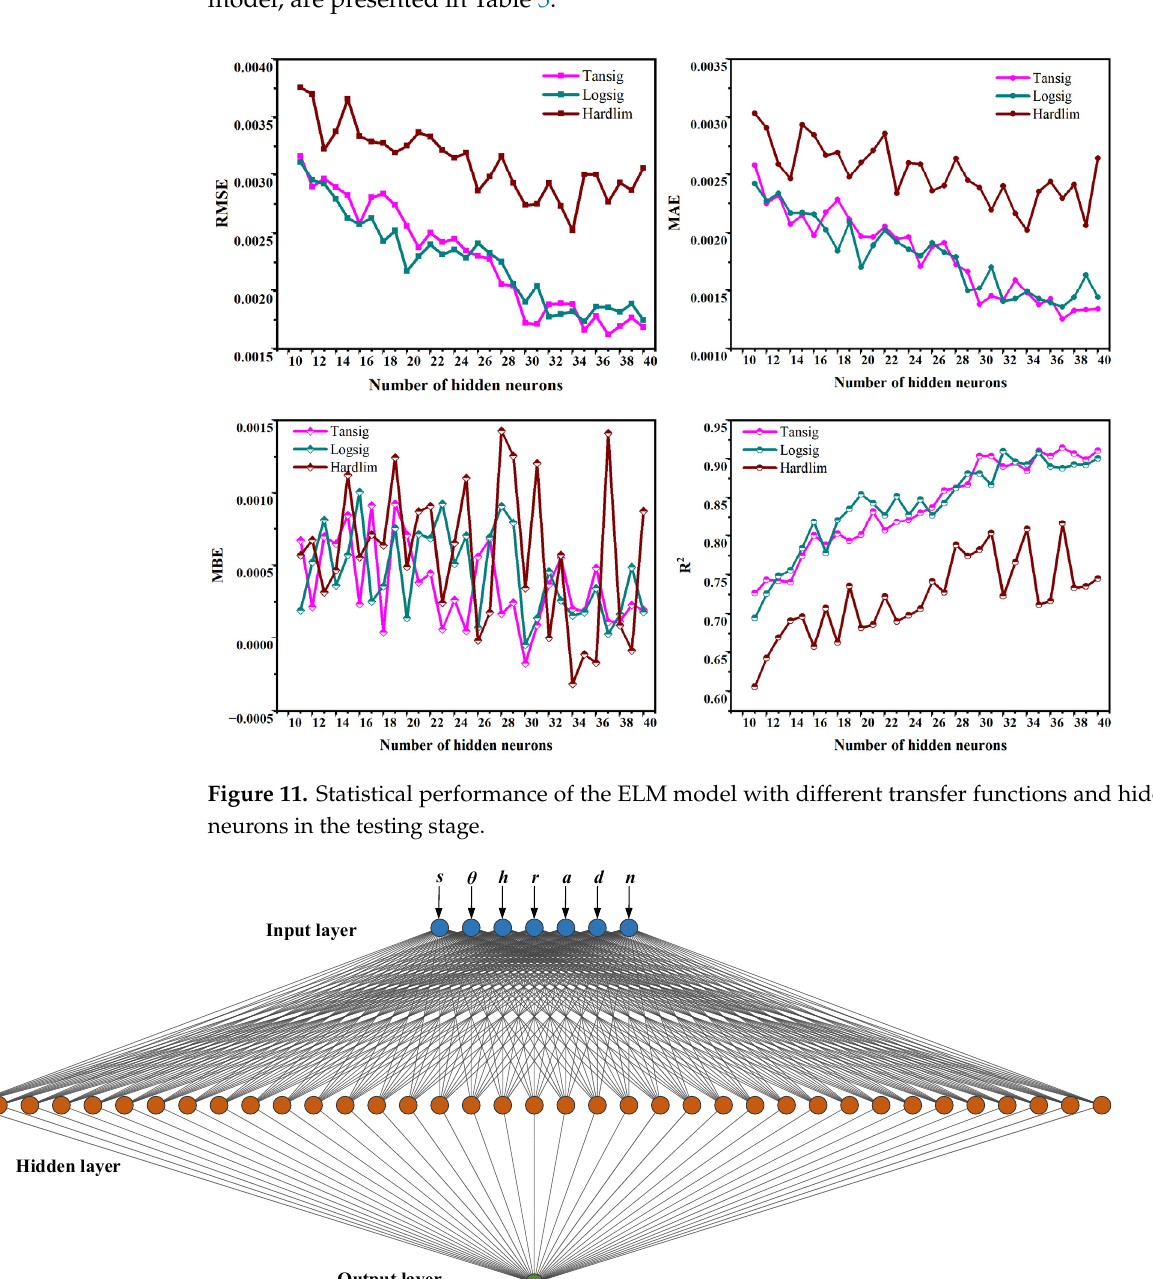
‐ ‐ 85.76% Table 5. Statistical prediction performance of the MLR model. Model